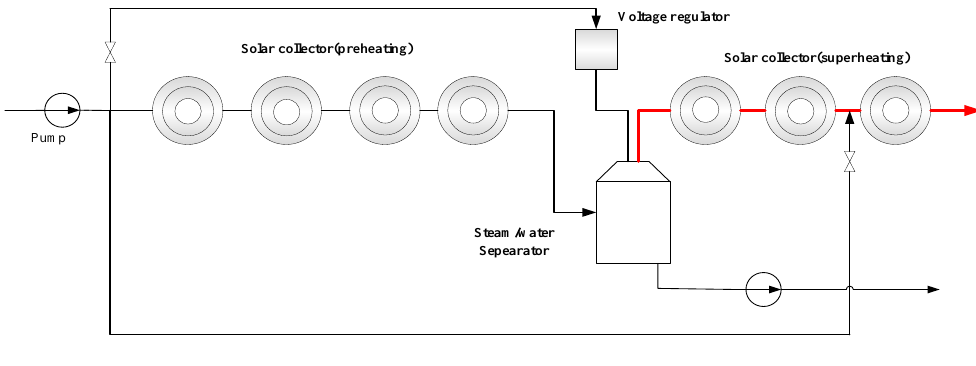
Figure 2. Solar field.